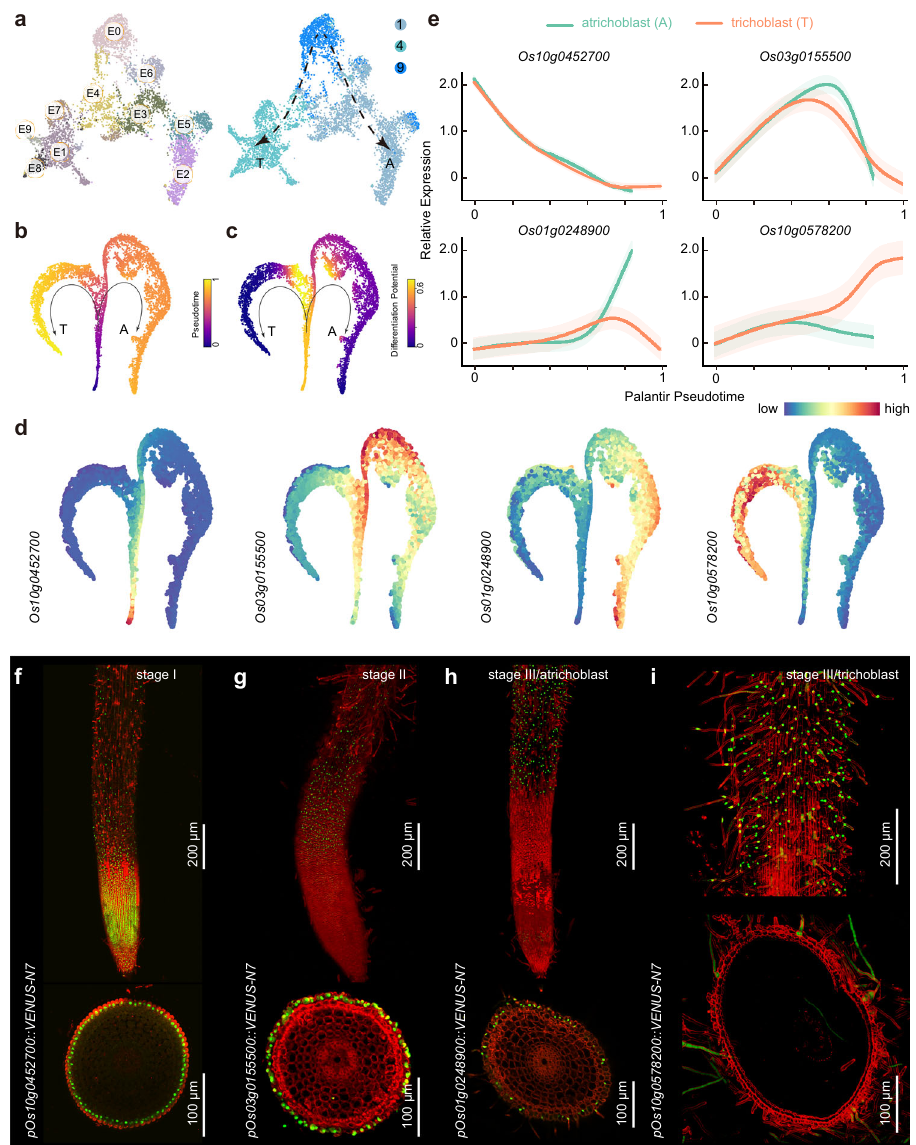
Fig. 2 Differentiation trajectories of epidermal cells. a UMAP projections showing epidermal cell populations (clusters 1, 4, and 9). E0 to E9, sub-cell clusters. Lines indicate two potential differentiation trajectories toward trichoblasts (T) and atrichoblasts (A). b , c t -SNE map of epidermal cell populations. Cells colored by Palantir pseudotime ( b ) or differentiation potential ( c ). d t -SNE map showing the expression pattern of four marker genes. e Expression of marker genes along Palantir pseudotime. f – i Expression of marker genes (green) in rice radicles. Three developmental stages (stage I to III) are shown. Six repeats each consisting of individual plants were performed for each gene. Red, FM4-64. Longitudinal (top) and transverse (bottom) sections are